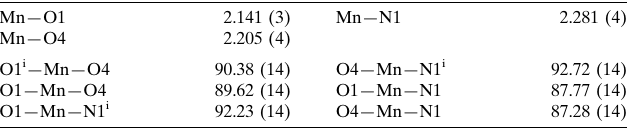
Selected geometric parameters (A˚ , (cid:2) ).